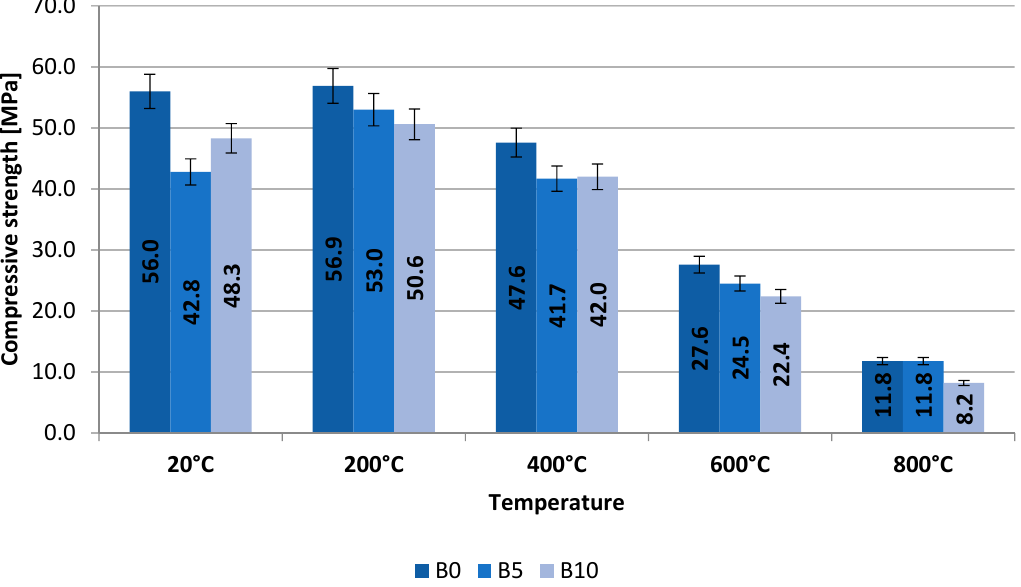
Figure 4. Results of testing of compressive strength obtained after 180 days.